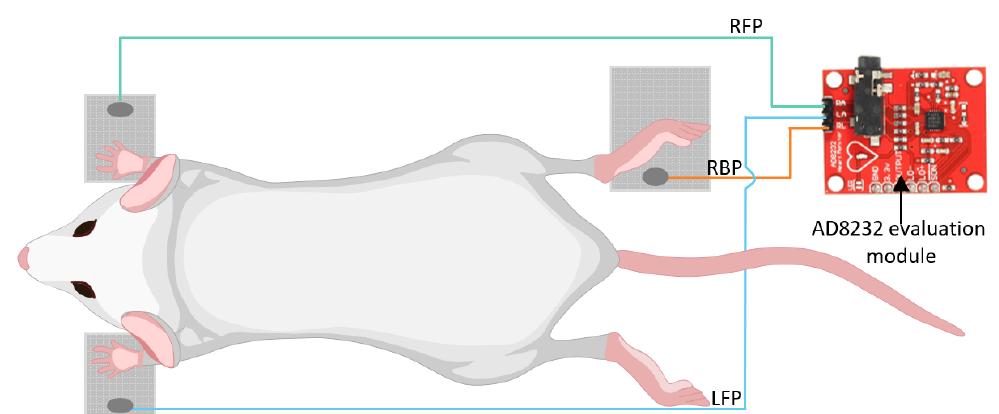
Figure 4. BALB/c mouse positioning in the ECG system with the 3 dry electrodes configuration and connections to the AD8232 evaluation module. RBP—Right Back Paw; RFP—Right Front Paw; LFP—Left Front